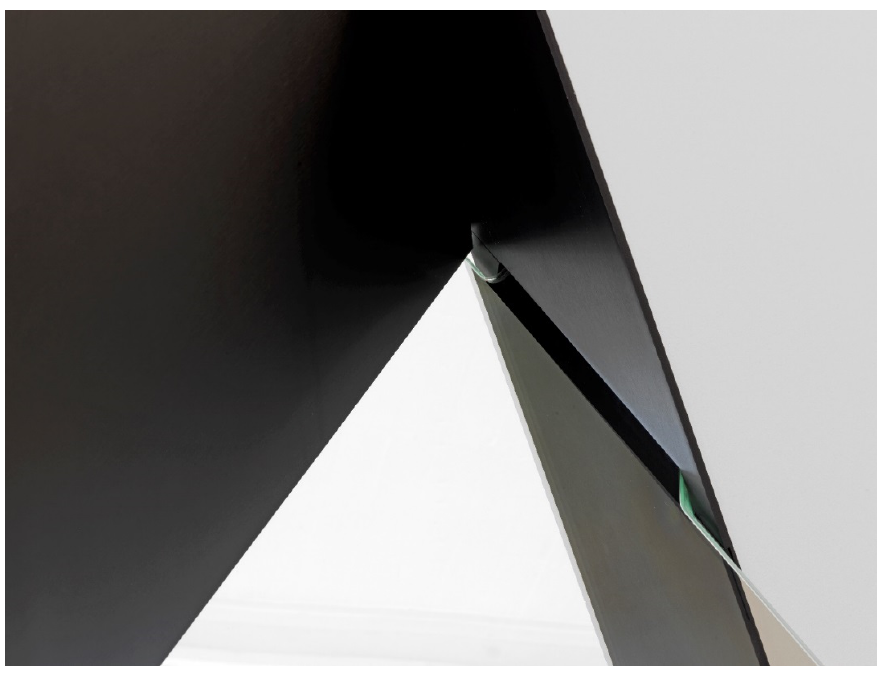
Fig. 22 33-D, 2014 | Realization of upper connection detail Photo Credit: Serge Hasenböhler